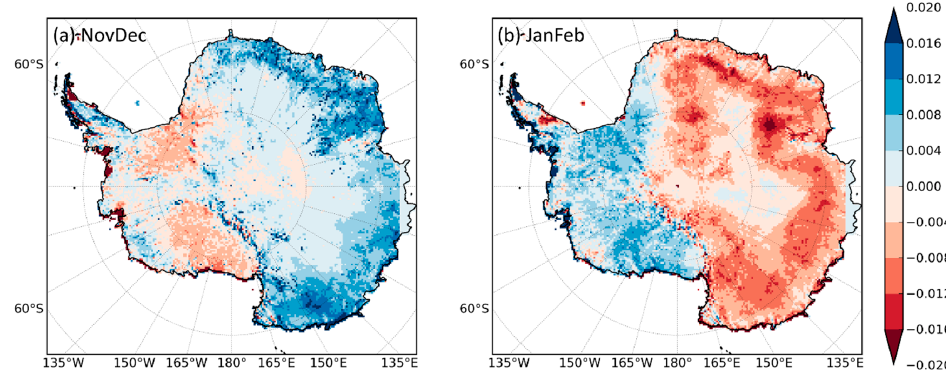
Figure 3. EOF-1 results of 2-month-average 1983–2009 albedo data: ( a ) November–December period; and ( b ) January–February period shown as change of albedo per year for each study period.